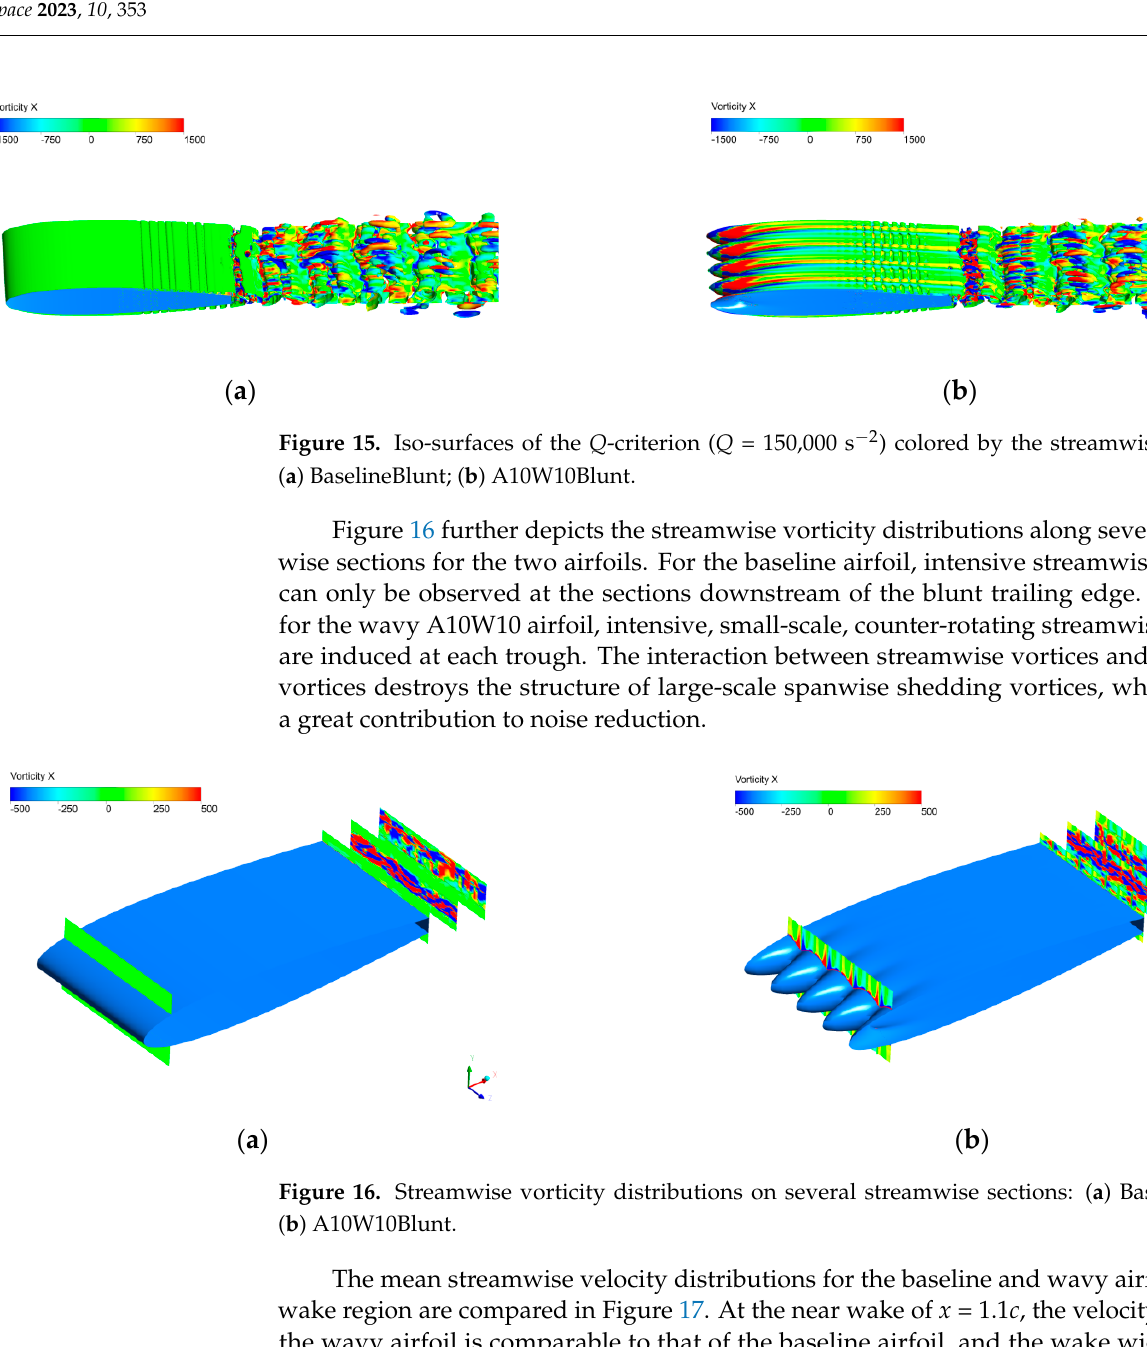
( c ) Figure 17. Distribution of the mean streamwise velocity in the wake region: ( a ) x = 1.1 c ; ( b ) x = 1.2 c ; ( c ) x = 1.3 c . The distributions of the streamwise velocity fl uctuations in the wake region are com- pared in Figure 18 for the two airfoils. It can be seen in Figure 18a that the turbulence intensity at the peak and middle of the wavy airfoil is decreased in the near wake of x =